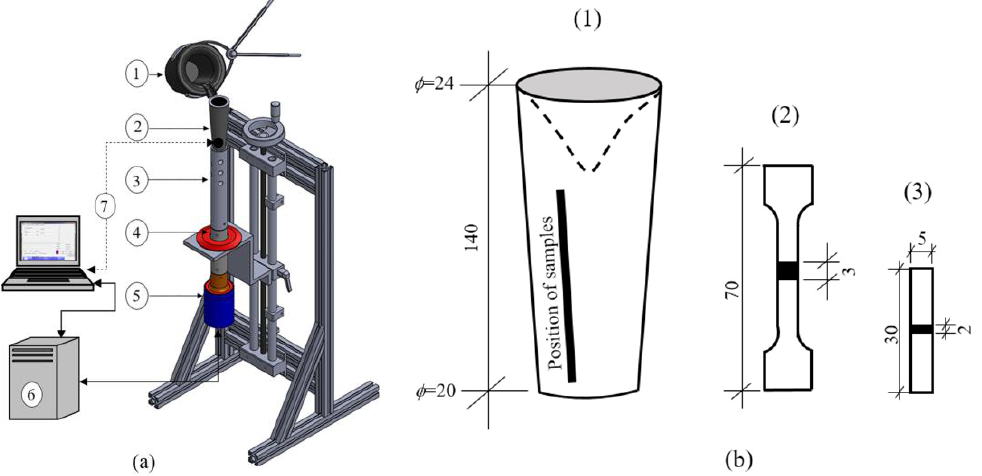
Figure 1. ( a ) Experimental setup: (1) crucible, (2) steel die, (3) waveguide, (4) booster and (5) 20 kHz Ttransducer, (6) MMM generator, (7) thermocouple sensor; ( b ) casted specimens: (1) casting, (2) tensile sample and (3) DMA